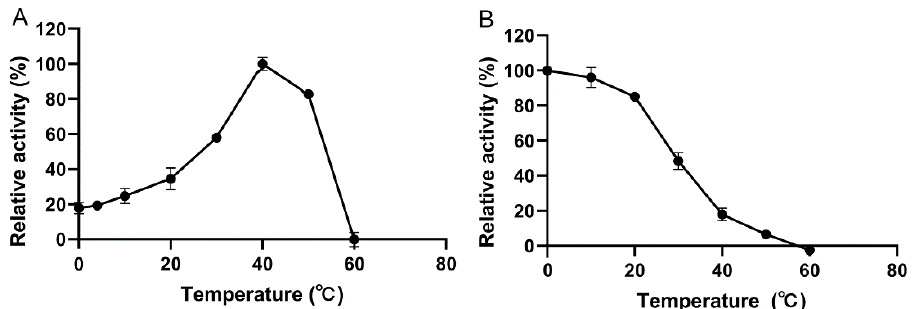
Figure 5. Optimal reaction temperature and temperature stability of YsHyl8A: ( A ) Optimal reaction temperature; ( B ) The temperature stability. The initial activity was defined as 100%. Error bars indicate the standard deviation ( n = 3).